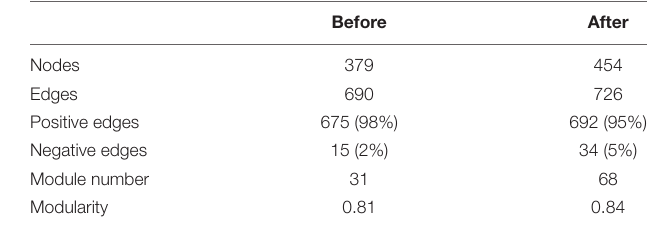
TABLE 3 | Topological properties of the before and after snowfall microbial networks.